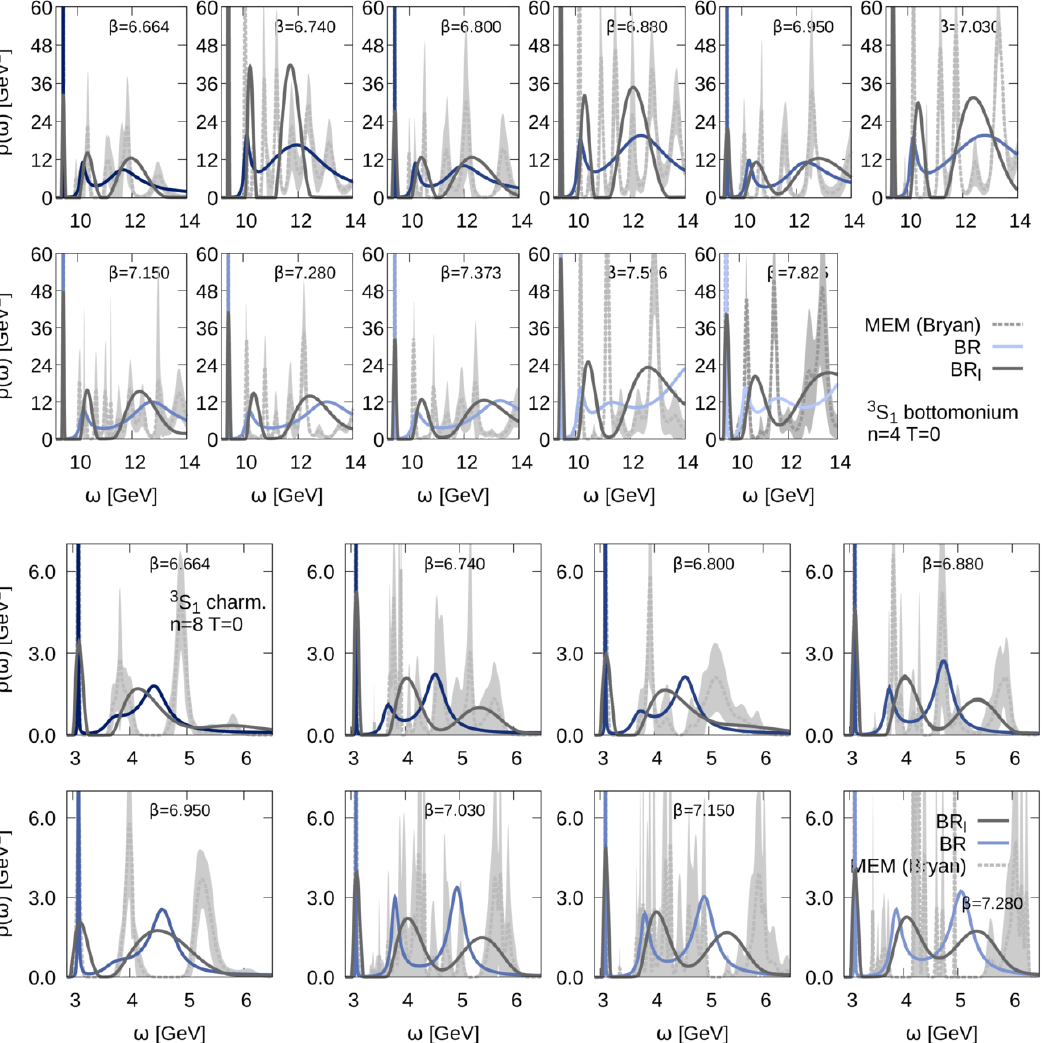
Figure 10 . Comparison of the spectral reconstruction of the bottomonium (top two rows) and charmonium (bottom two rows) 3 S 1 S-wave ground state peak among di(cid:11)erent reconstruction al- gorithms: BR method (colored solid), Maximum Entropy Method (gray dashed) and the smooth BR ‘ method (gray solid). Note that with the settings (cid:20) = 1 the BR ‘ method produces the peaks with lowest amplitude and largest (arti(cid:12)cial) width, followed by the MEM and the BR method, as expected produces the sharpest features. Note that the peak apex from the BR ‘ method remains very close to the position located by the standard BR method.